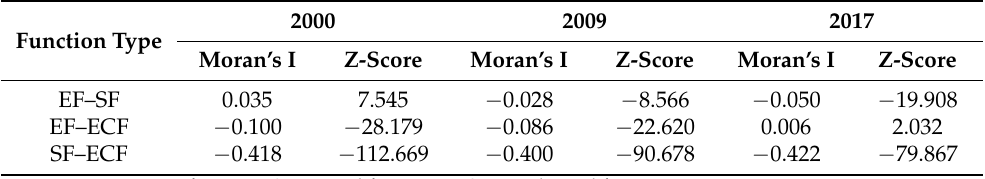
Table 2. Bivariate global Moran’s I indices ( p < 0.05) and the Z-scores of land use primary functions in